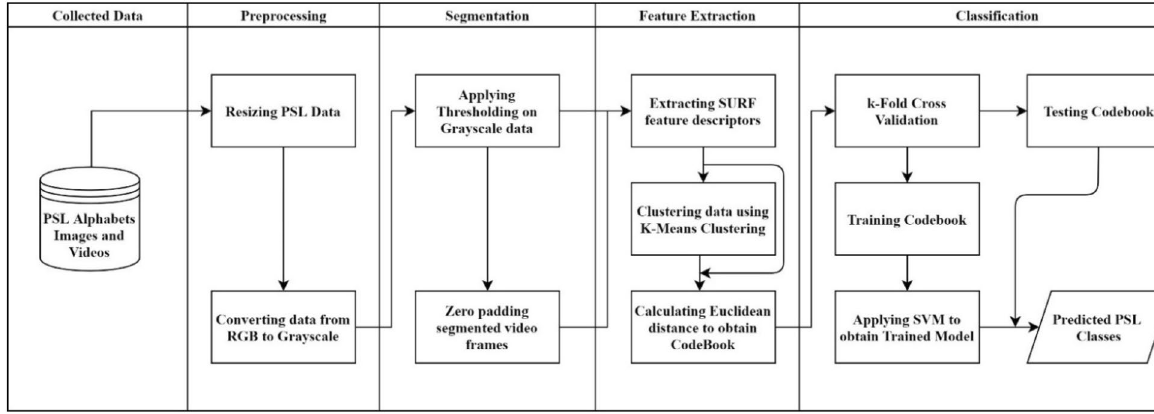
Figure 3. PSL recognition flowchart.